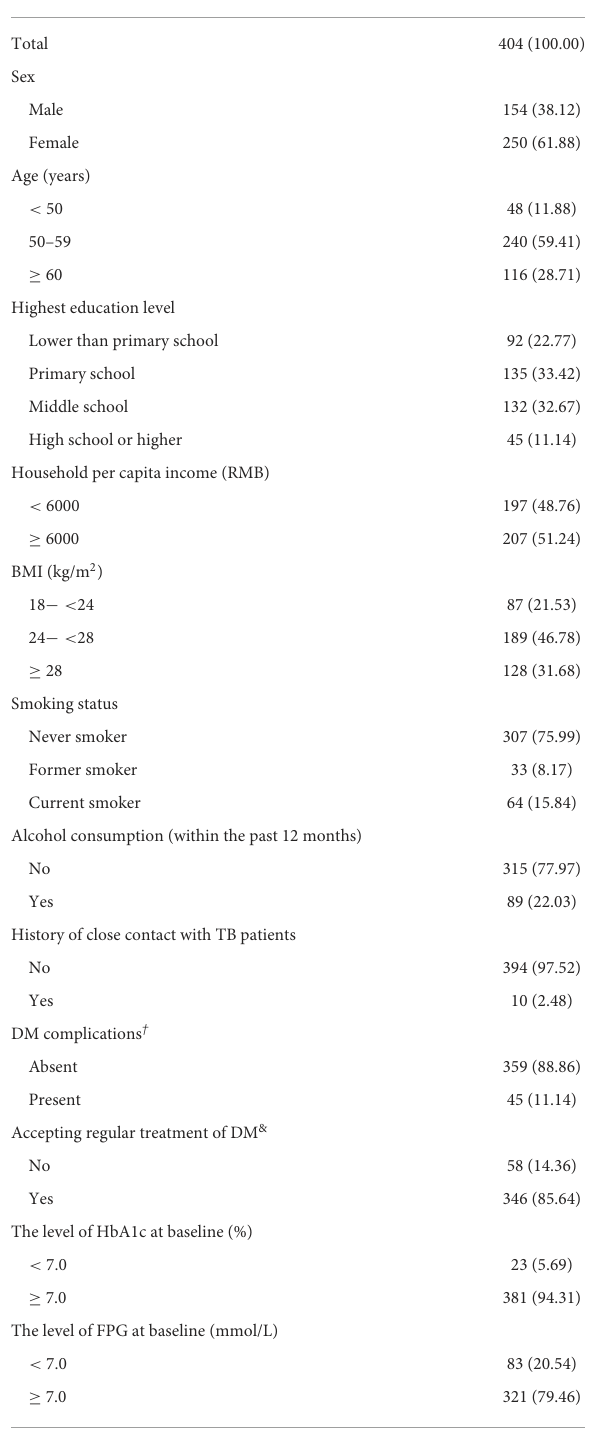
TABLE 1 Characteristics of the study